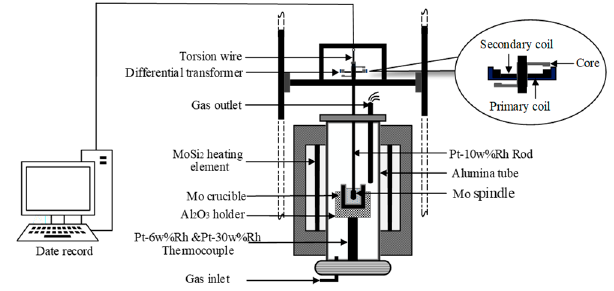
Figure 3. Viscosity measuring